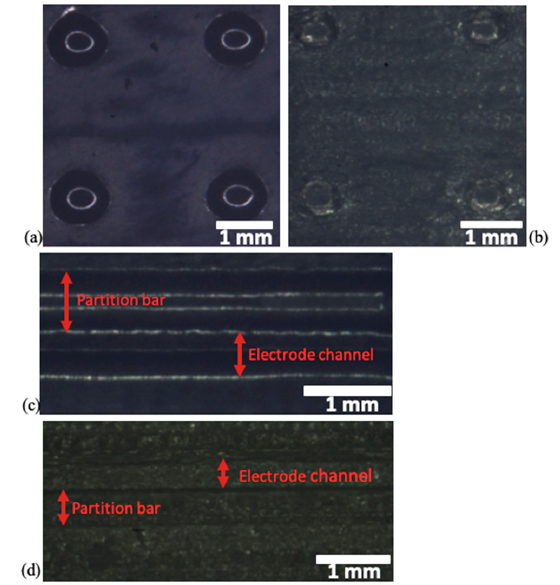
Figure 4. Optical microscope images: ( a ) pillars in the glossy surface device, ( b ) pillars in the matte surface device, ( c ) partition bar and electrode channel in the glossy surface device and ( d ) partition bar and electrode channel in the matte surface device.